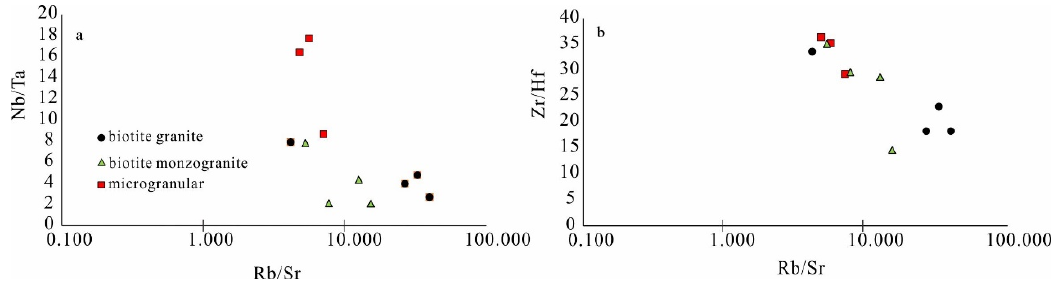
Figure 11. Variations of Rb/Sr versus Nb/Ta ( a ) and Zr/Hf ( b ) from the Xitian intrusion.